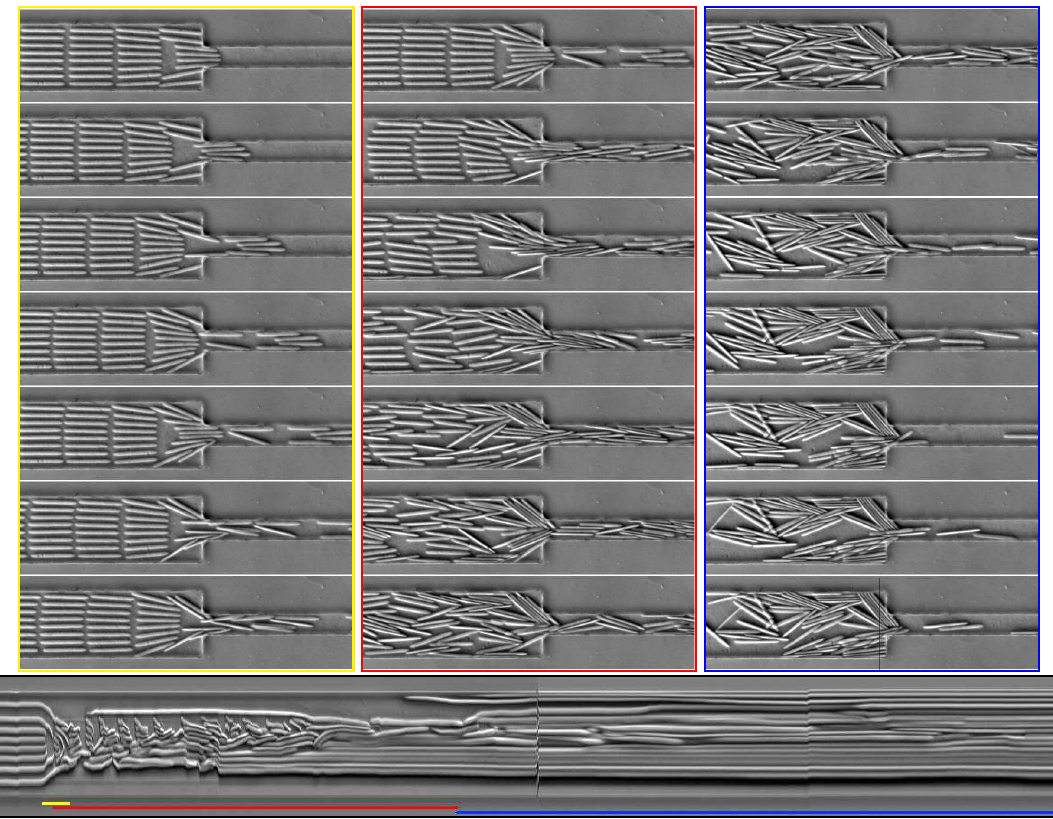
Figure 13. Time series of images showing the behavior of a suspension of 200 µ m-long fibers, oriented parallel to the flow, which goes from left to right on the pictures. The first column (yellow) focuses on the initial times (200 ms between frames); the second column (red) shows the lateral symmetry breaking on a longer time scale (3 s after applying the flow, 3 s between frames); and the third column (blue) shows later times (20 s after applying the flow, 6 s between frames). The suspension changes from an ordered spatial organization to a disorganized state, which evolves very slowly. The bottom image is a spatio-temporal representation. Time is represented as the x -axis going from left to right ( ≈ 60 s in total), whereas the y -axis represents a line from each picture always positioned at the same place and indicated as a black line on the bottom right image. The colored lines indicate the start and duration of corresponding sets of images shown above. The corresponding video is available in Supplementary Materials Video